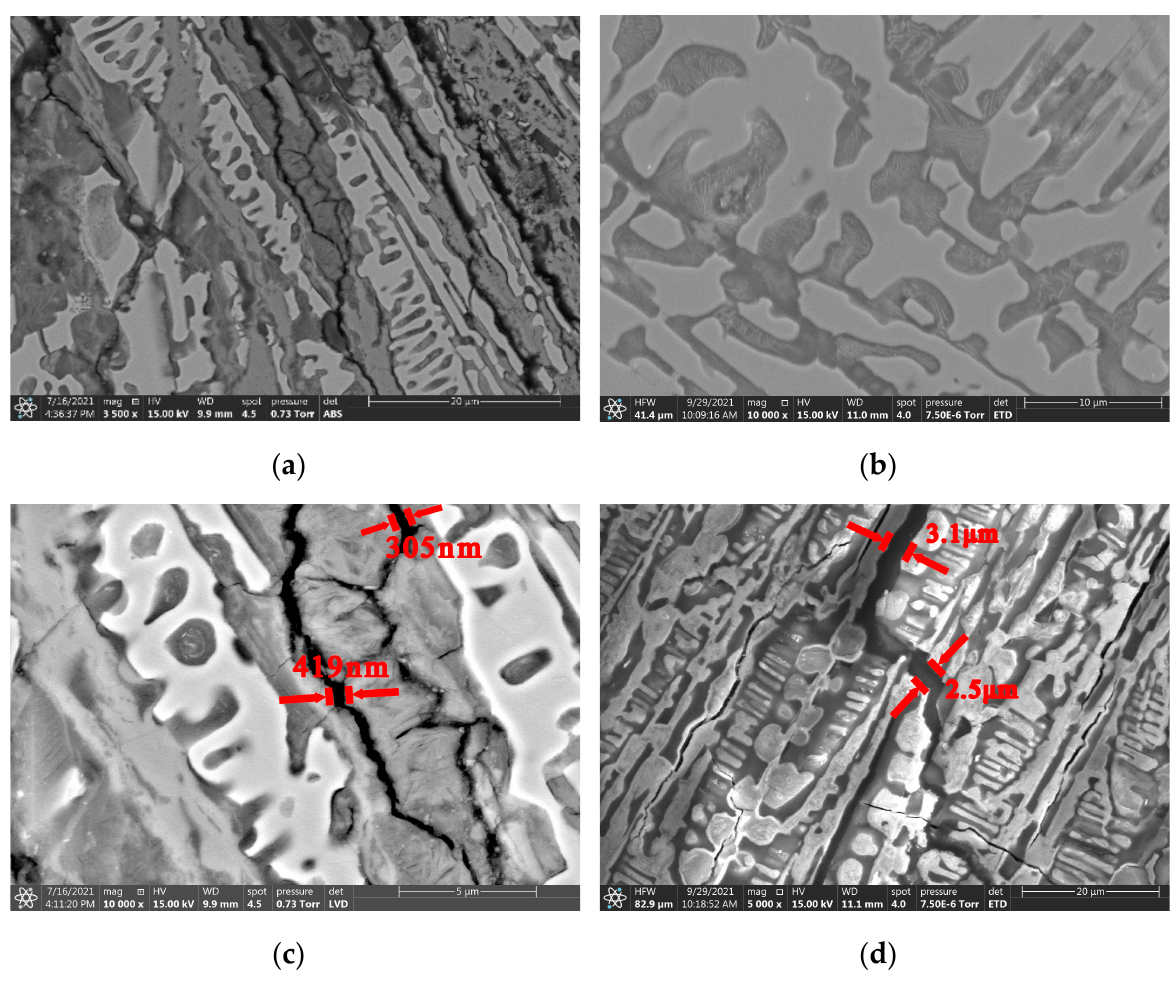
Figure 5. Existence and distribution of inner microcracks in the iron matrix. ( a ) Existence and distribution of inner fractures in the iron matrix. ( b ) “Concave surface” formed by prior corroded ferrite. ( c ) Microcracks of ferrite. ( d ) Microcracks tearing cementite.